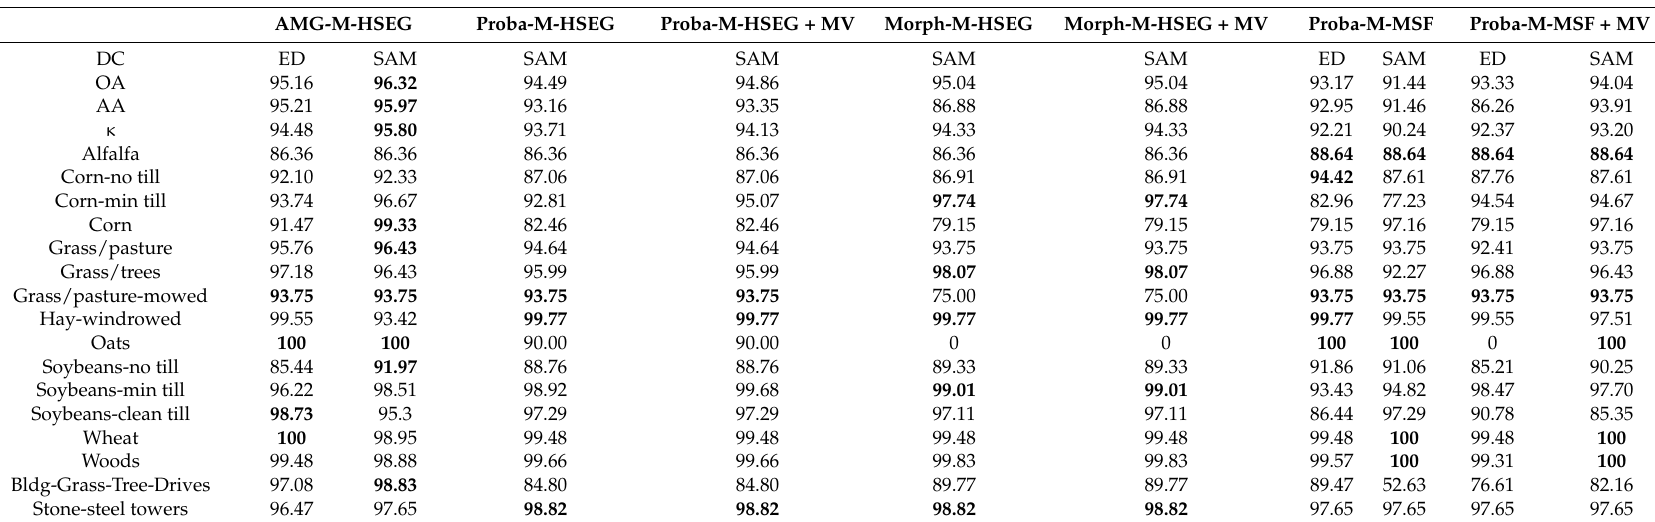
Table 2. The GAs and CAs (percent) for the Indian Pines image using all the spectral-spatial classification methods for comparison. The highest accuracies are indicated in bold in each